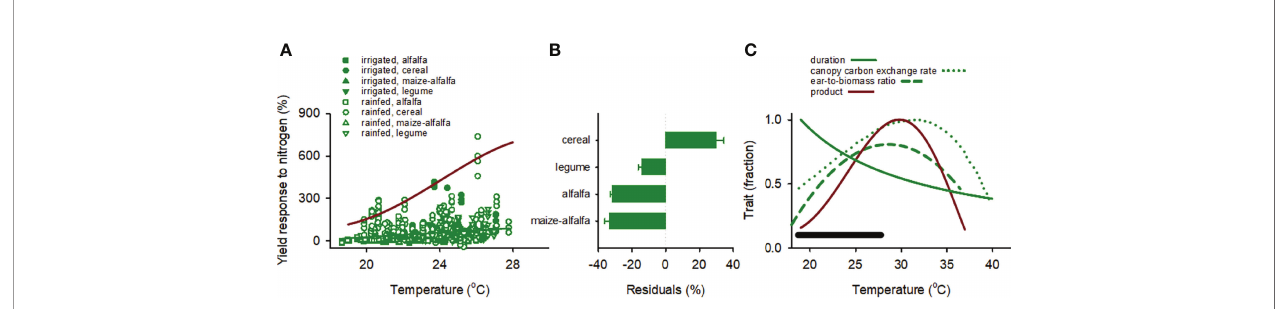
FIGURE 7 | (A) Yield response to nitrogen as a function of mean temperature in the critical period for irrigated and rainfed maize grown after alfalfa, cereal, maize- alfalfa, and legume in the US. Response to nitrogen is: 100 · (Y N -Y 0 )/Y 0 where Y is yield, and subscripts indicate fertilised (N) and unfertilised control (0). The green line is the least squares regression fi tted to the data. The red line is the product of three traits: duration of the critical period, canopy carbon exchange rate and ear- to-biomass ratio from (C) , scaled to the actual maximum. (B) Average residuals of the regression between yield response to nitrogen and temperature for maize grown after alfalfa, cereal, maize-alfalfa, and legume. Error bars are one standard error. (C) Duration of the critical period, canopy carbon exchange rate, ear-to- biomass ratio and the product of the three traits as a function of mean temperature. The black segment is the range of temperature in our data set. Duration of the critical period is from our data set. The functions for canopy carbon exchange rate and ear-to-biomass ratio are from Kim et al. (2007) at CO 2 concentration = 370 mmol mol -1